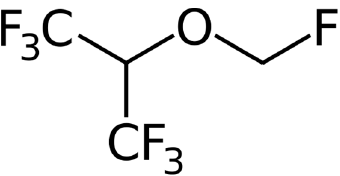
Figure 1. Chemical structure of sevoflurane.